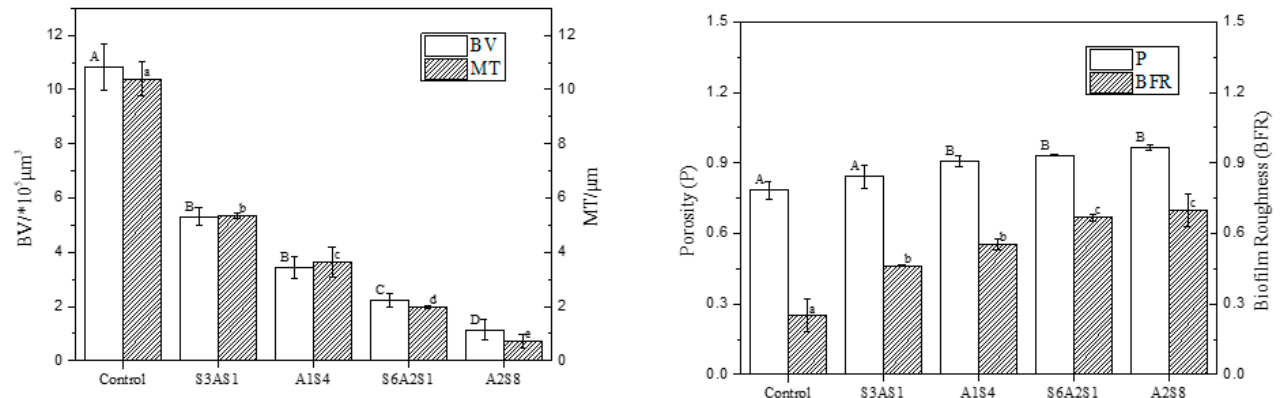
Figure 13. The CLSM images analysed by ISA-2 software to determine the biovolume (BV), mean thickness (MT), porosity (P) and biofilm roughness (BFR) of the biofilm. Data were expressed by mean measurements ± standard deviation (SD) and all treatments and determinations were per- formed in triplicate. The different letters indicate significant differences ( p < 0.05).